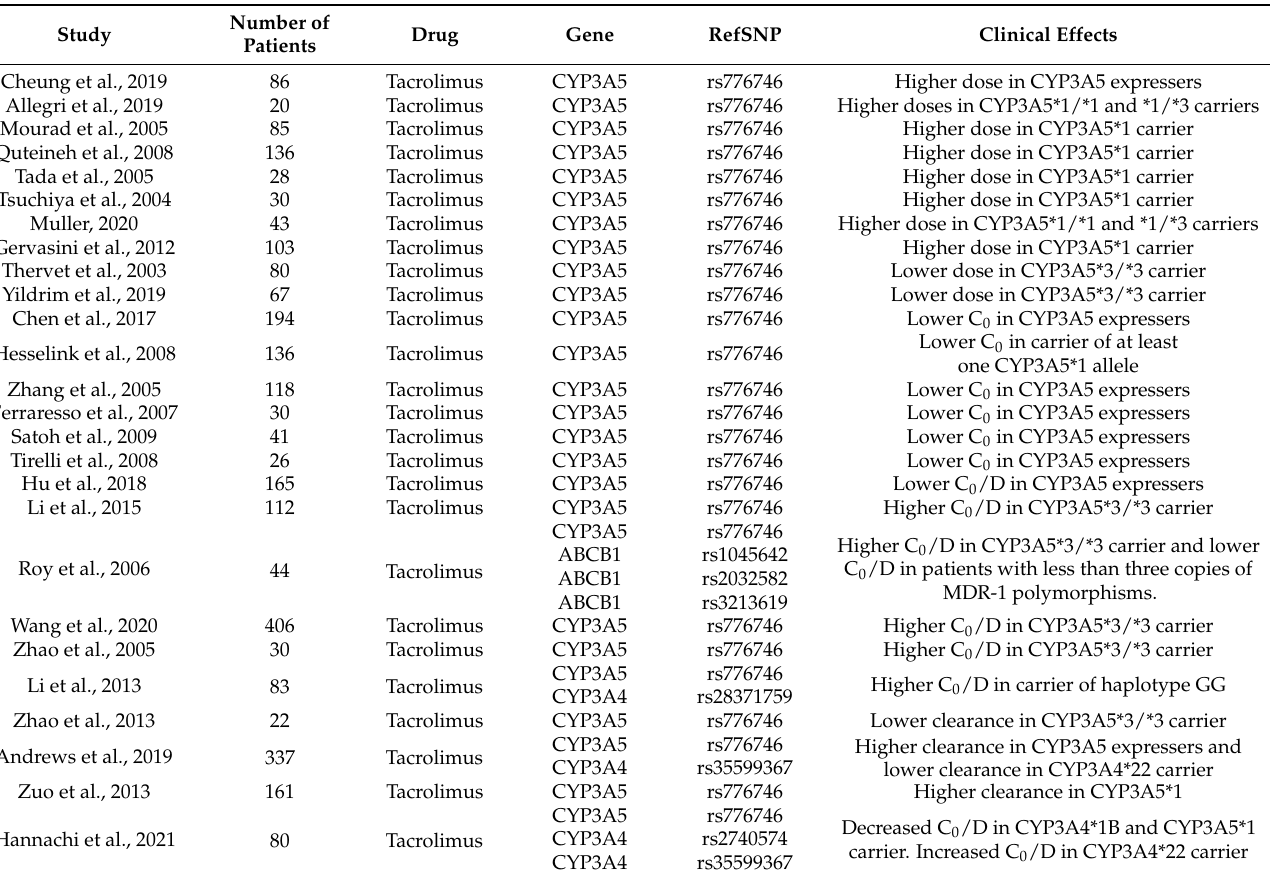
Table 1. Summary of studies on pharmacogenetics of